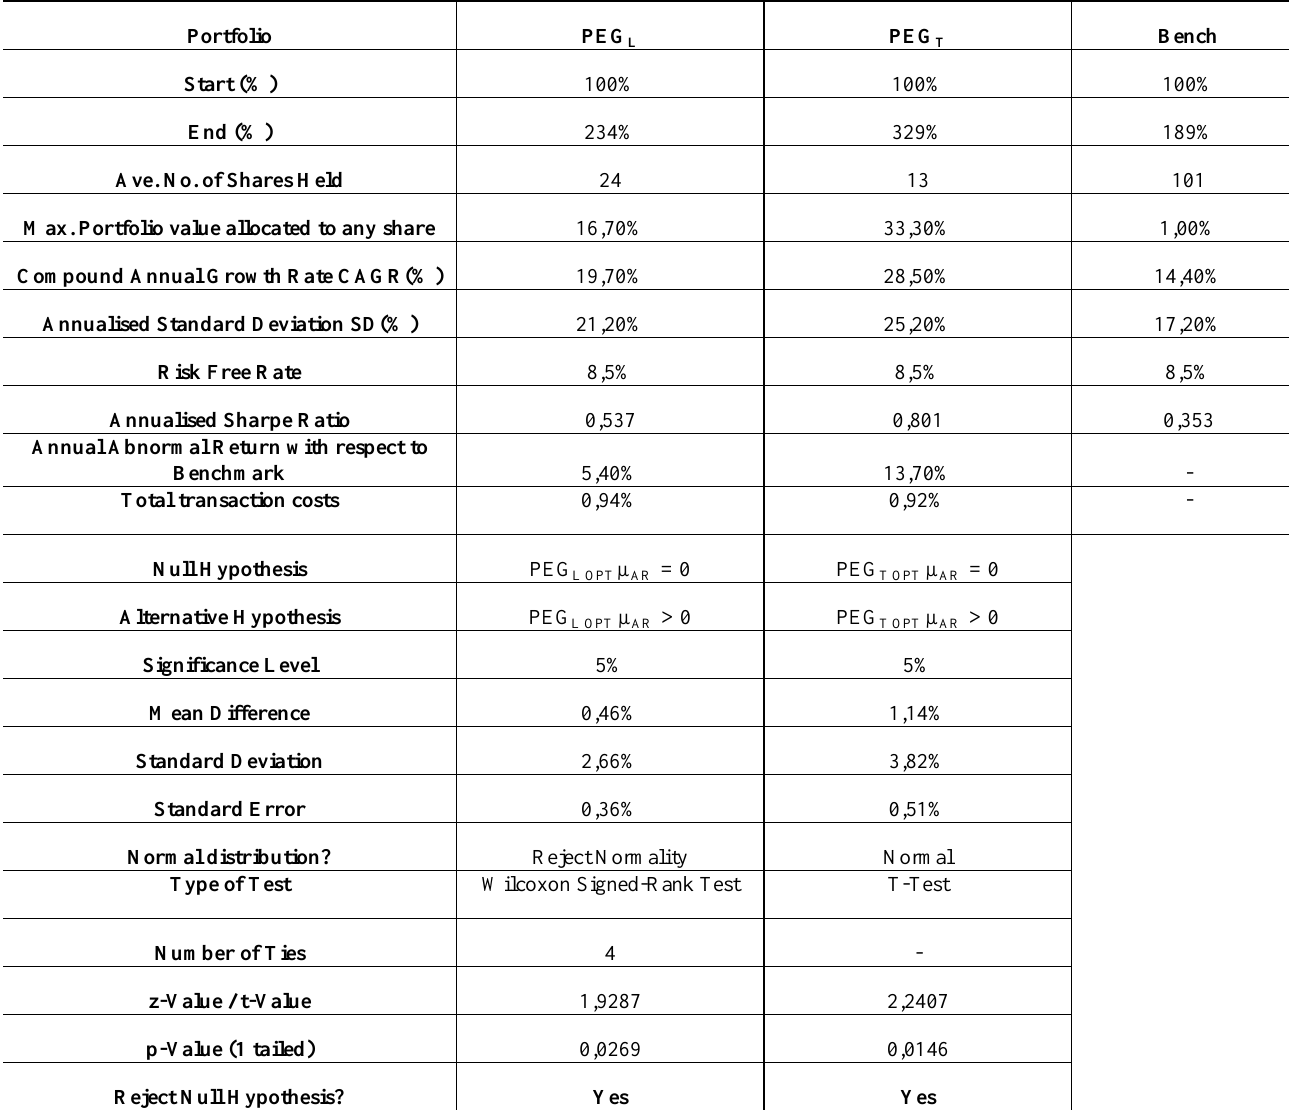
Table 5: Portfolio performances of optimal PEG trading rules